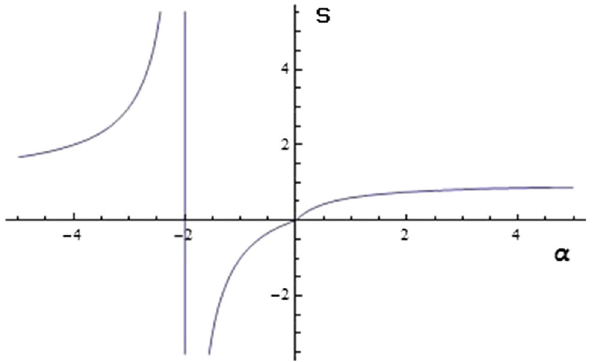
Fig. 3 The parameter S and a function of α for the case β = ( 3 / 4 )α 2 . Note that the function has a discontinuity for the case α = −